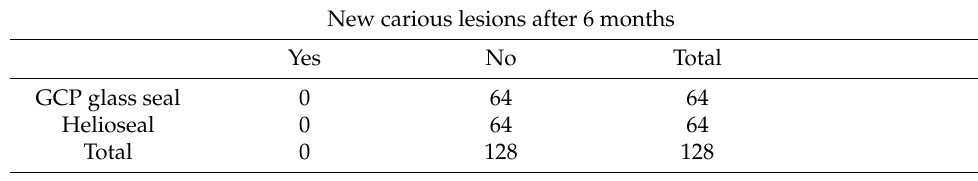
Table 2. Incidence of new carious lesions after 6, 12, 18, and 24